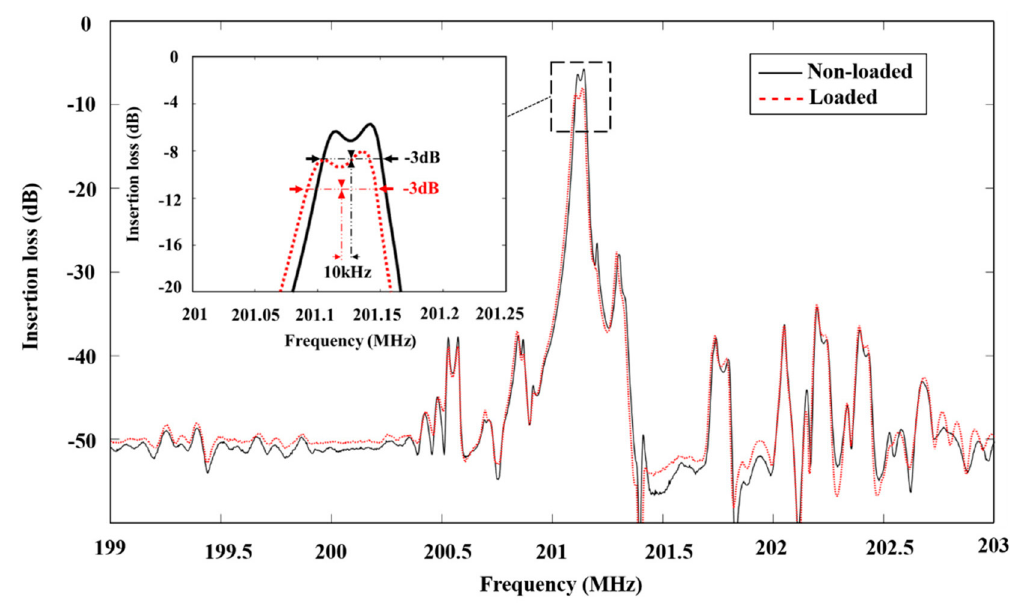
Figure 10. Measured result of the frequency response before and after